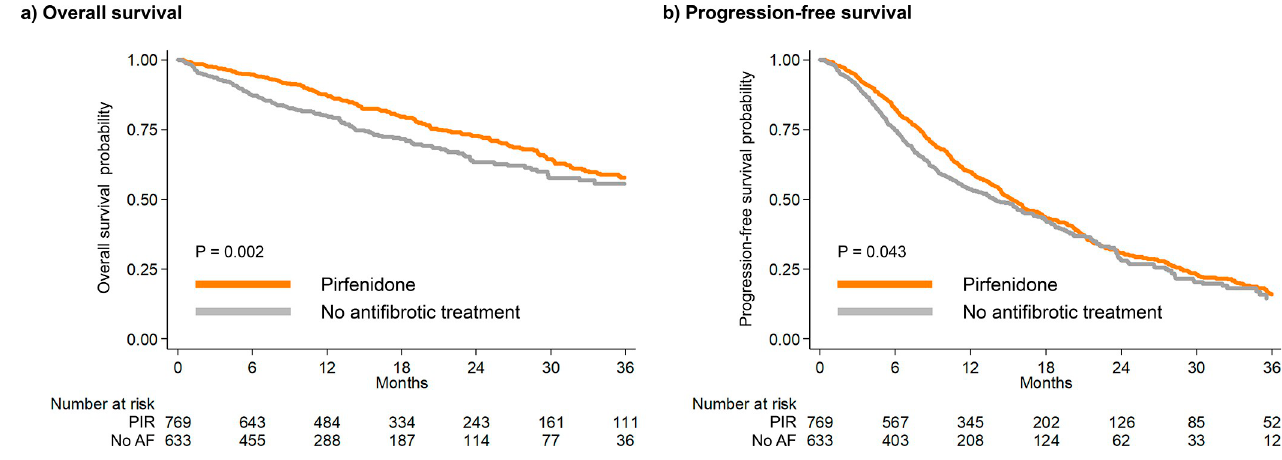
Fig 1. Overall survival (a) and progression-free survival (b) in the whole IPF cohort.